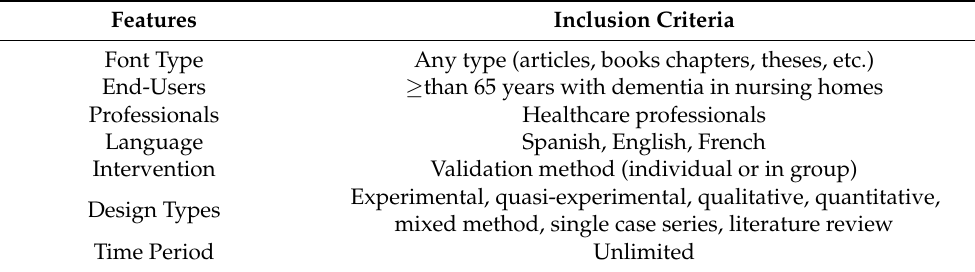
Table 1. Study’s inclusion